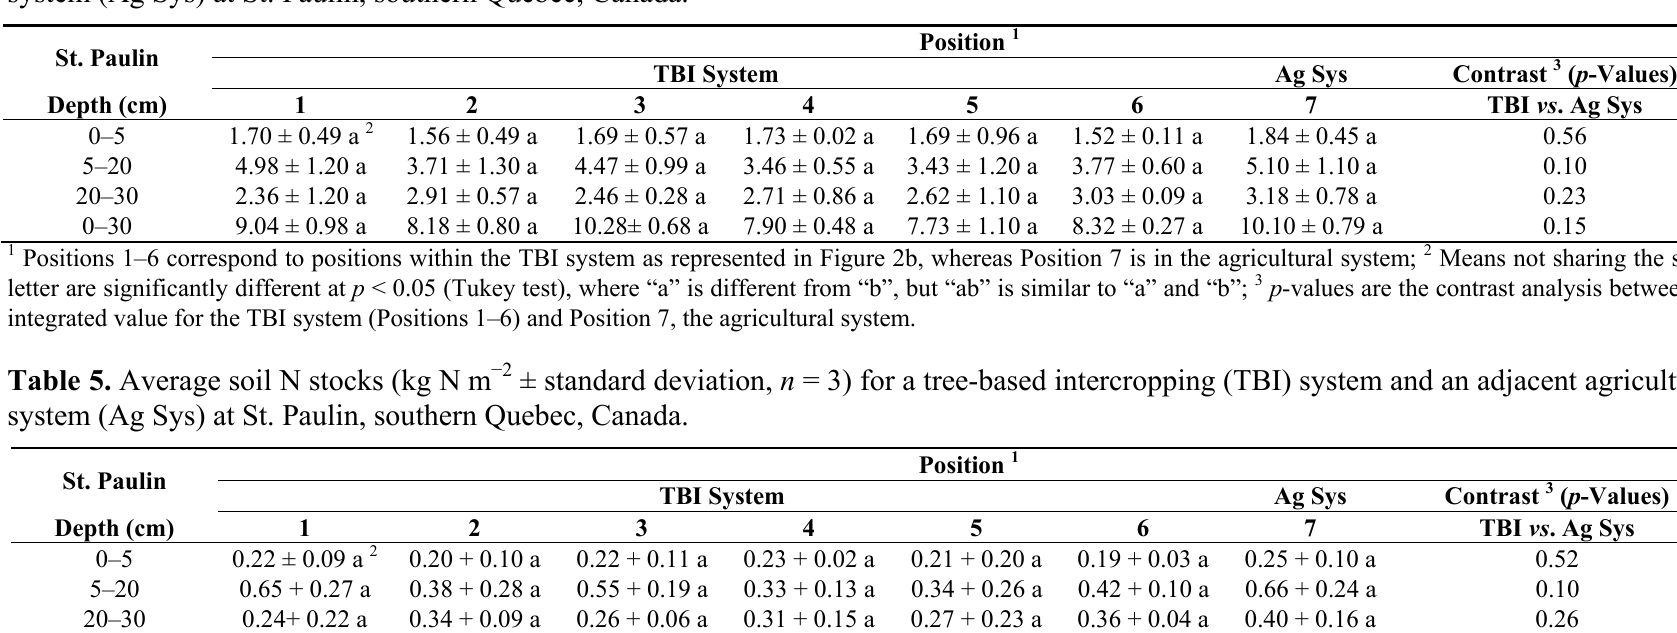
Table 4. Average soil C stocks (kg C m − 2 ± standard deviation, n = 3) for a tree-based intercropping (TBI) system and an adjacent agricultural system (Ag Sys) at St. Paulin, southern Quebec, Canada.